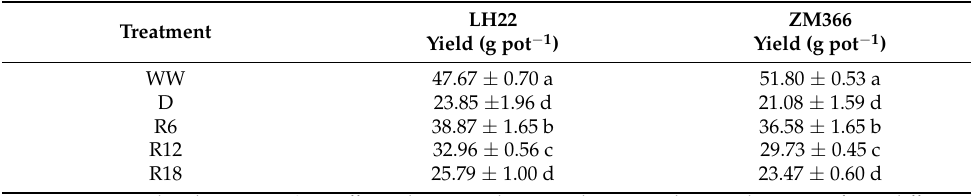
Table 1. Effects of different treatments on grain yields of wheat.